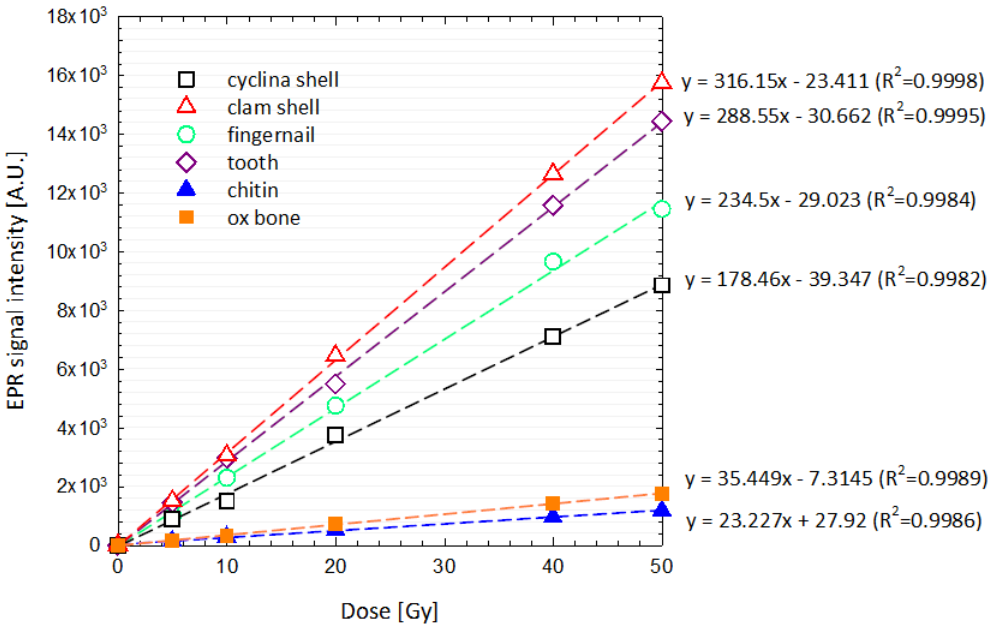
Figure 3. Dose response curve for the six biological samples.